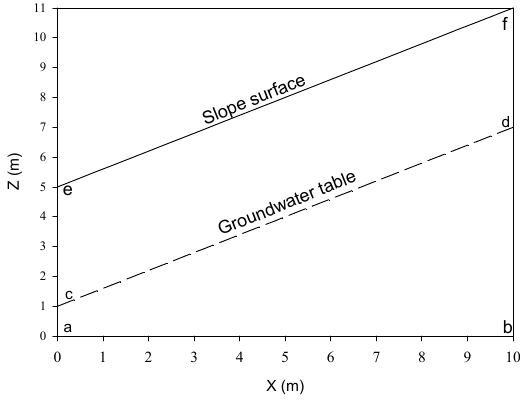
Figure 3. Geometry of modeling slope.